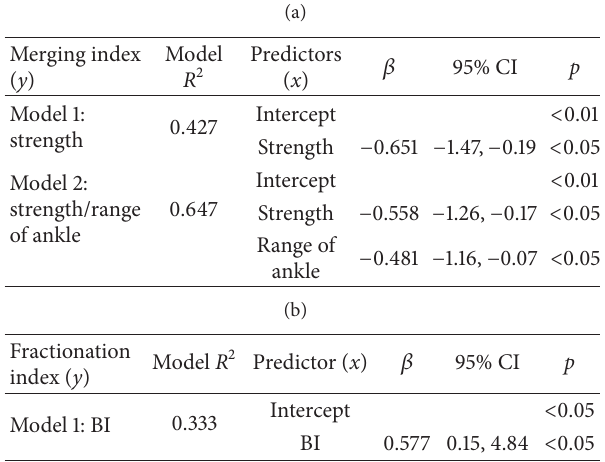
Table 4: Results of multiple linear regression analysis of gait